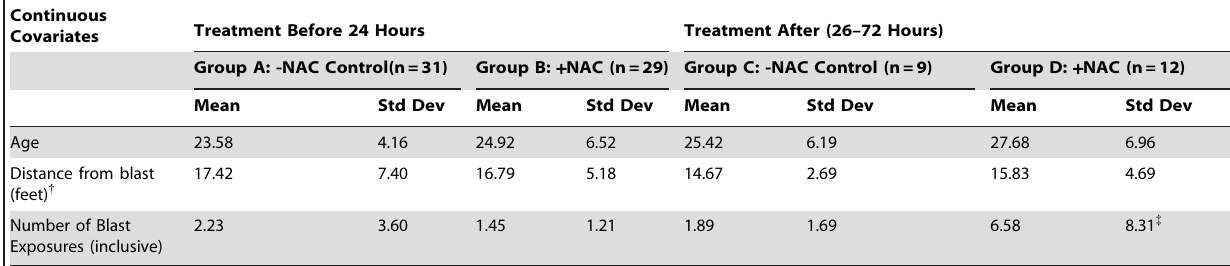
Table 1. Study Group